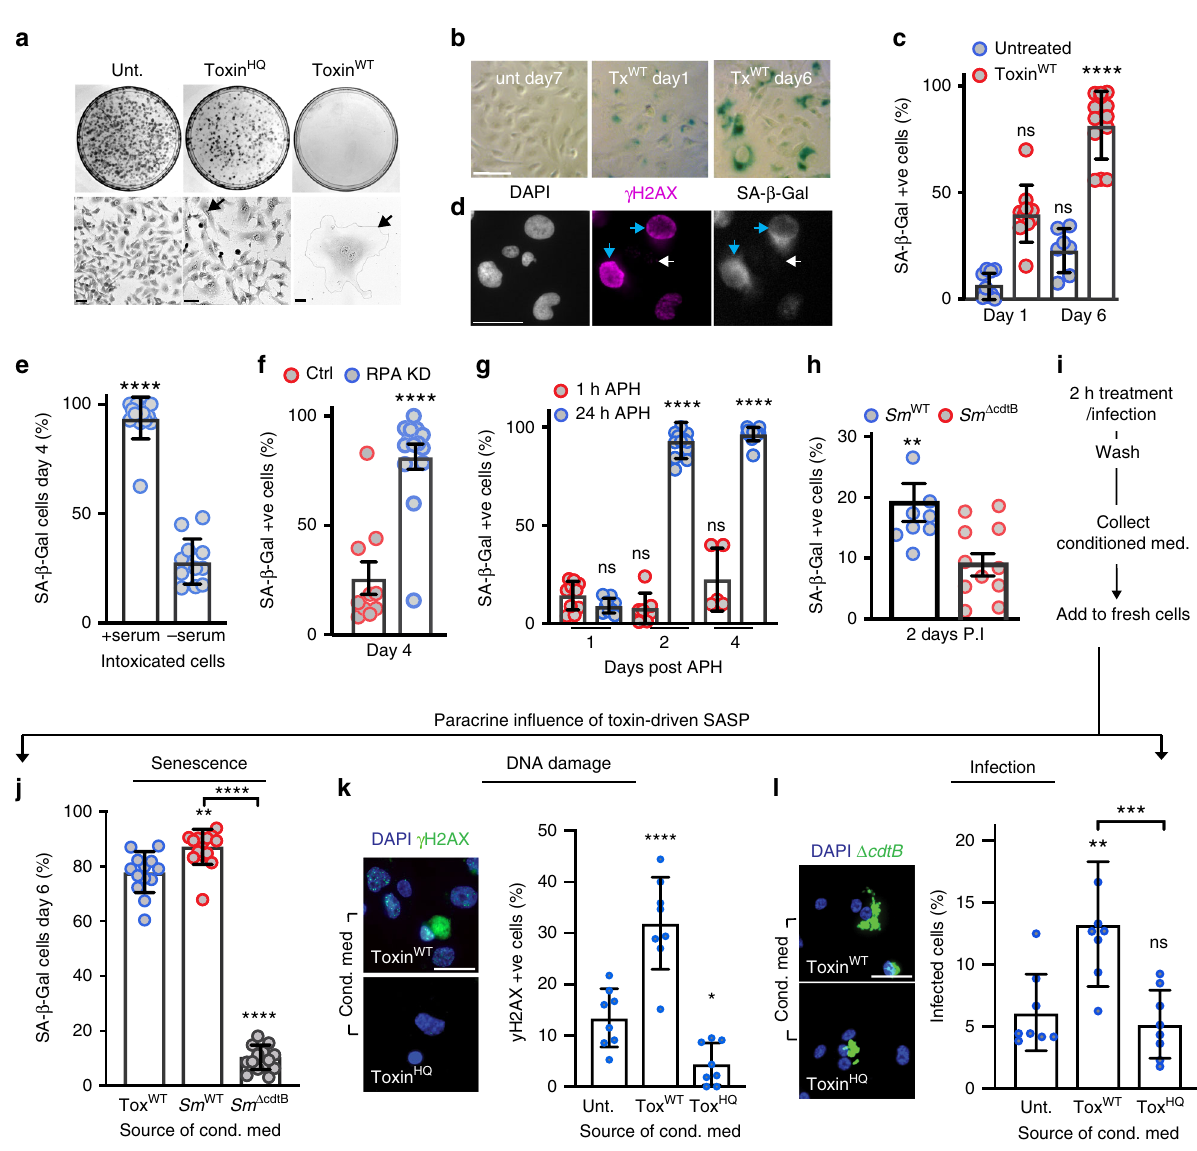
Fig. 5 RING-induction by the toxin drives senescence and infection. a Representative image of toxin-induced cell growth arrest and distension. HT1080s either untreated or treated with toxin WT or toxin HQ for 2 h before imaging at 7-days. Cell colonies (top panel) and high-magni fi cation images (bottom panel). Arrows mark individual cells. Scale bars 50 μ m. b Representative image of SA- β -Gal activity in intoxicated cells. Scale bars 50 μ m. c Proportion of intoxicated cells with SA- β -Gal activity relative to untreated. Analysed 1700 cells/variable, error bars SD. d Representative image of toxin-induced SA- β - Gal in γ H2AX RING cells at 48 h. Blue arrows indicate senescent RING cells ( γ H2AX in magenta/SPiDER β -Gal in grayscale) and distended nuclei (DAPI, greyscale). White arrows indicate non-senescent cells. Scale bars 50 μ m. Proportion of cells with SA- β -Gal activity following ( e ) intoxication with toxin